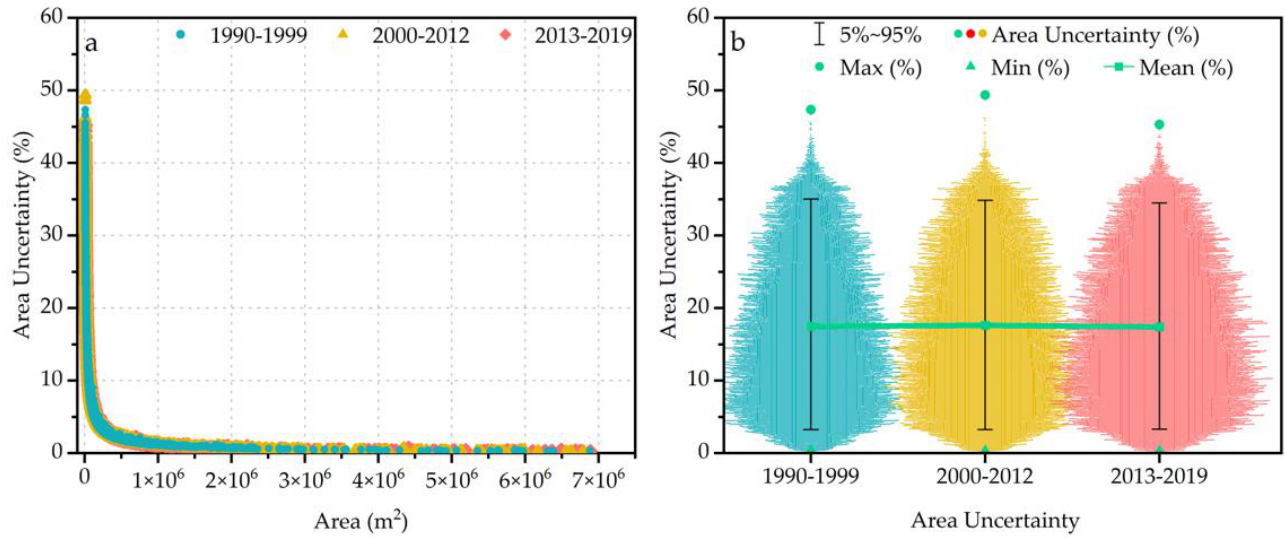
Figure 4. ( a ) Relationship between the area of each glacial lake and its uncertainty in the TP; ( b ) descriptive statistics of the glacial lake area uncertainty; the swarm plots for each time period represent the uncertainty distribution of all glacial lakes in that period.